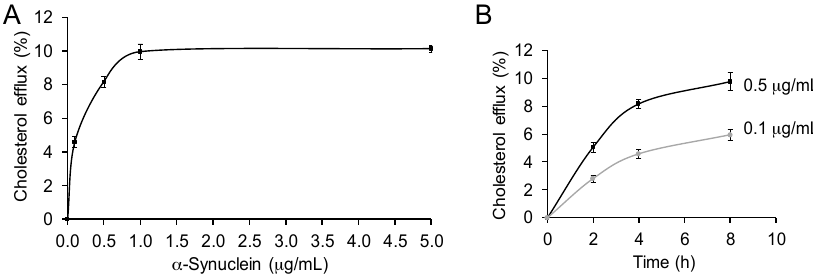
Figure 2. α -Synuclein mediates cholesterol efflux in a dose and time dependent manner. ( A ) Cholesterol efflux of SK-N-SH neuronal cells with increasing concentrations of α -synuclein (4 h treatment); ( B ) Cholesterol efflux of SK-N-SH neuronal cells with increasing exposure time to α -synuclein (0.1 and 0.5 µg/mL). Data represent mean ( n = 6) and SE as error bars.